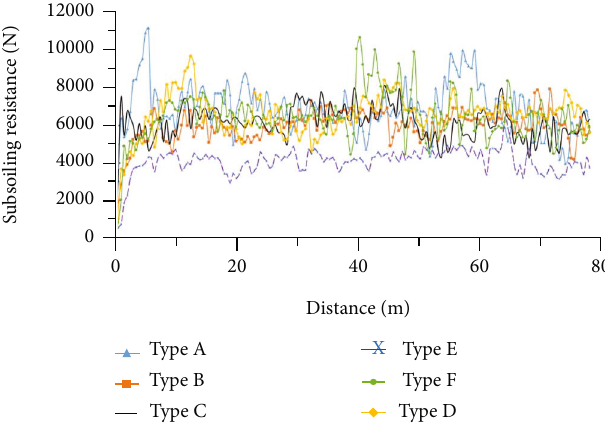
Figure 13: Variation of subsoiling resistance with distance for six subsoilers at 7 km/h speed and 30cm depth.